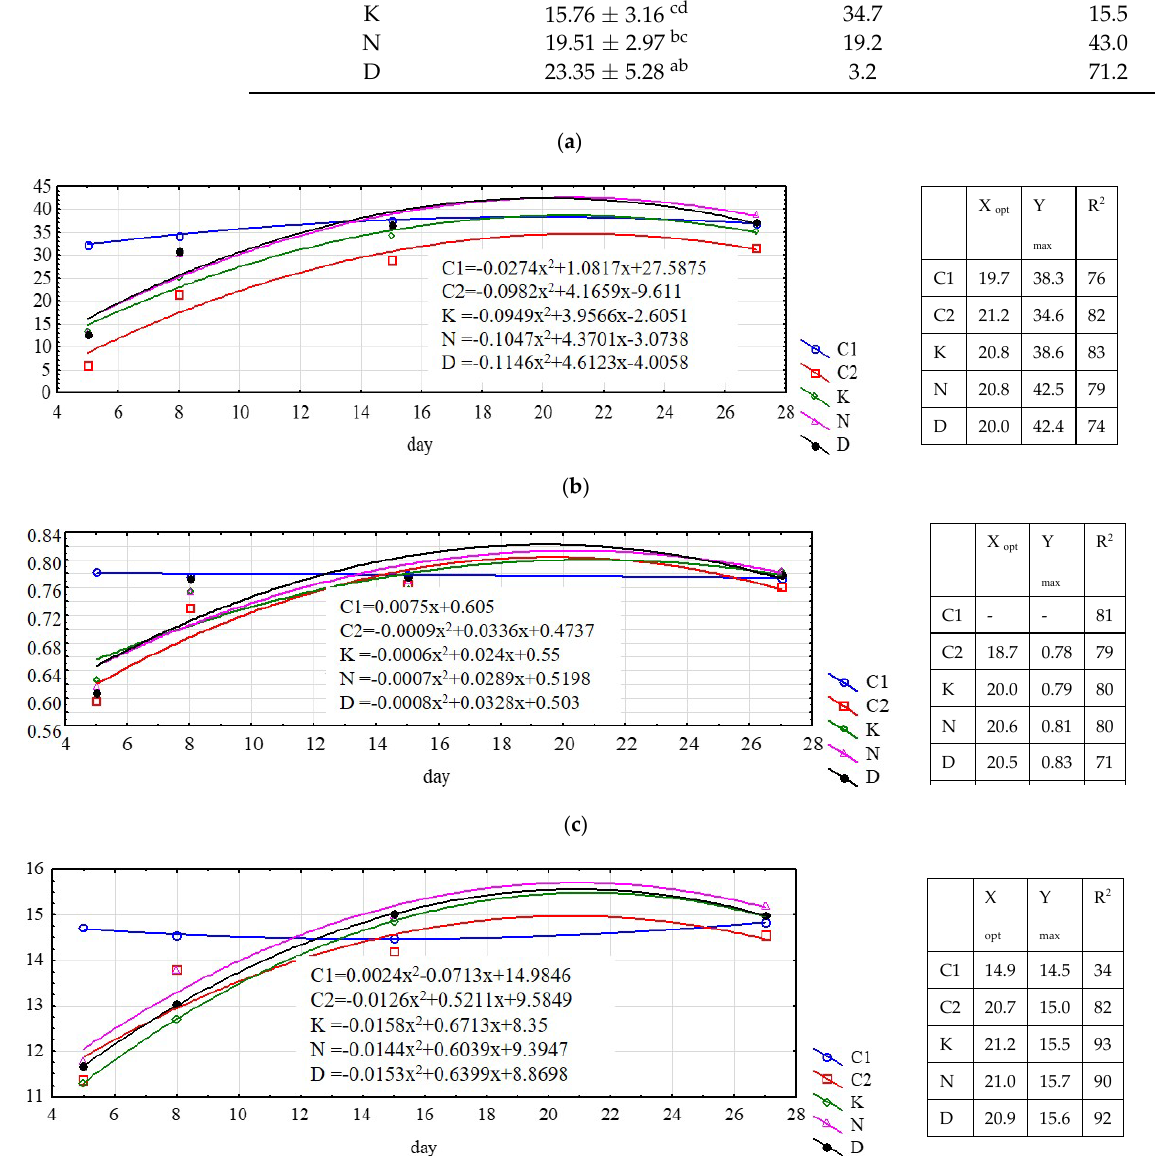
Figure 3. Effects of phytostimulators and time of measurements on maximum net photosynthetic